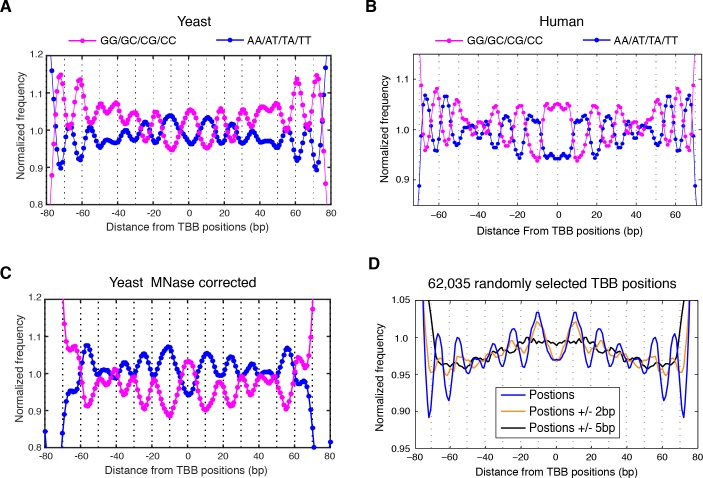
Dinucleotides frequency of nucleosome positions.(A–C) Normalized frequency of AA/AT/TA/TT and CC/CG/GC/GG dinucleotides of DNA sequences aligned at the centers of nucleosomes, for all TBB nucleosome positions in yeast, both before (A) and after (C) correction for MNase digestion bias, and for all TBB nucleosome positions on human chromosome 12, position 38,000,000 bp to 48,000,000 bp, a 10 Mbp region randomly chosen in the human genome (B). (D) The frequency of AA/AT/TA/TT for 62,035 randomly selected TBB nucleosome positions (blue trace), and for genome locations with an average distance of either 2 bp (orange trace) or 5 bp (black trace) from these selected TBB nucleosome positions. The distance was randomly perturbed by between 0–4 bp or 0–10 bp for each nucleosome positions, respectively.